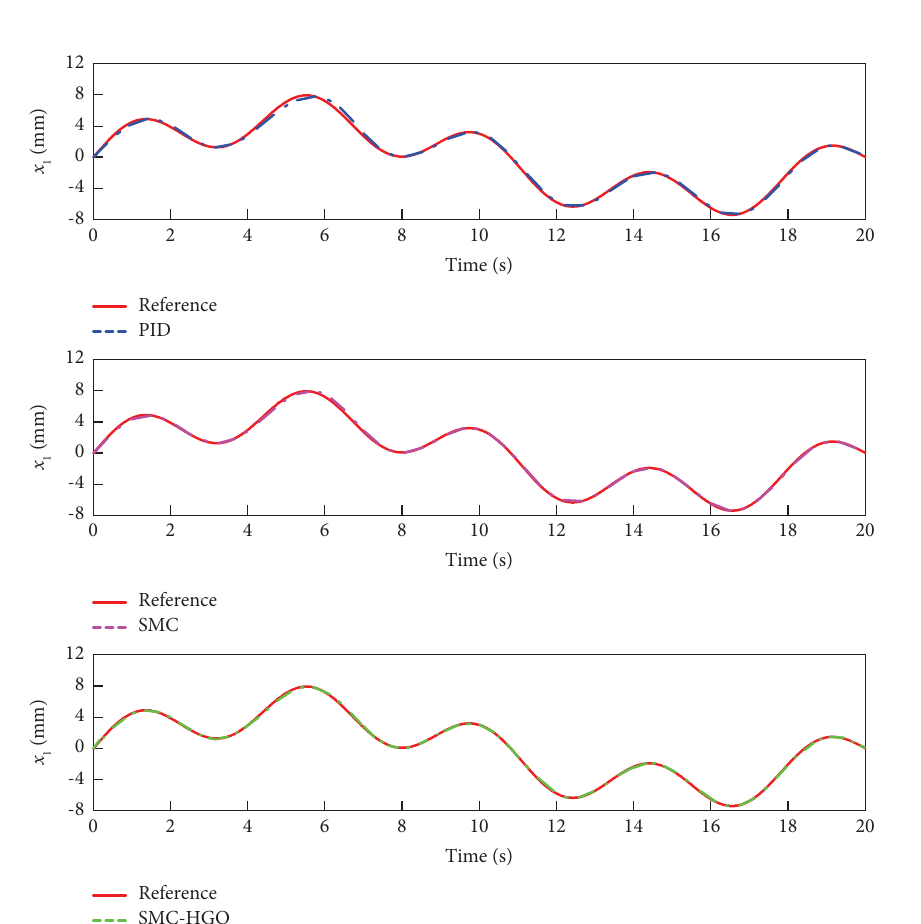
Figure 8: Comparative tracking performance of multifrequency sinusoidal